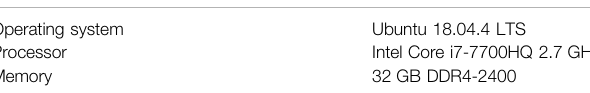
TABLE 4 | Speci fi cations of the executing